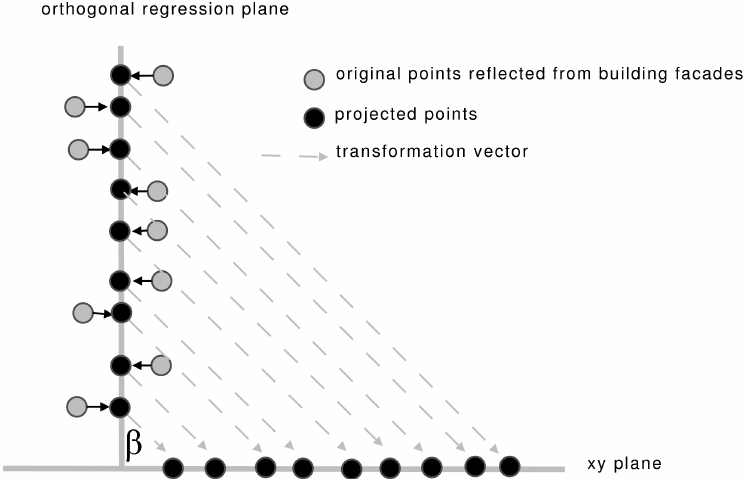
Figure 3. Points being reflected from building facades are projected on the XY-plane in order to apply 2D alpha shapes and calculate the area of each building facade, respectively.